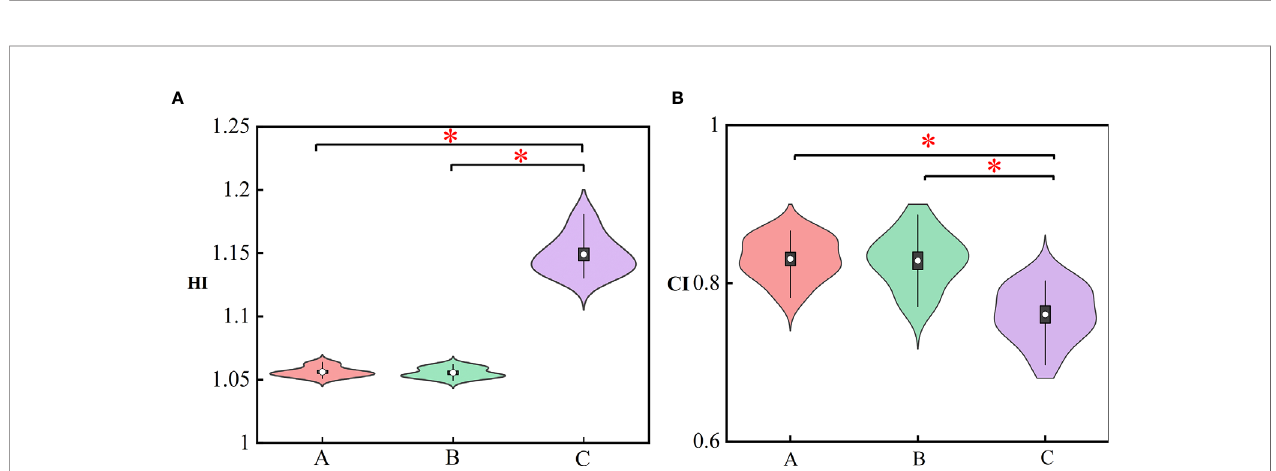
FIGURE 4 | Violin plots representing the mean (white dot), s (vertical rectangle), 95% percentile (black vertical line) and the probability distribution for the HI (A) and CI (B) . The asterisks represent p ≤ 0.05. (A) Manual plan, (B) dose prediction-based post-optimization plan and (C) MSE optimization plan.